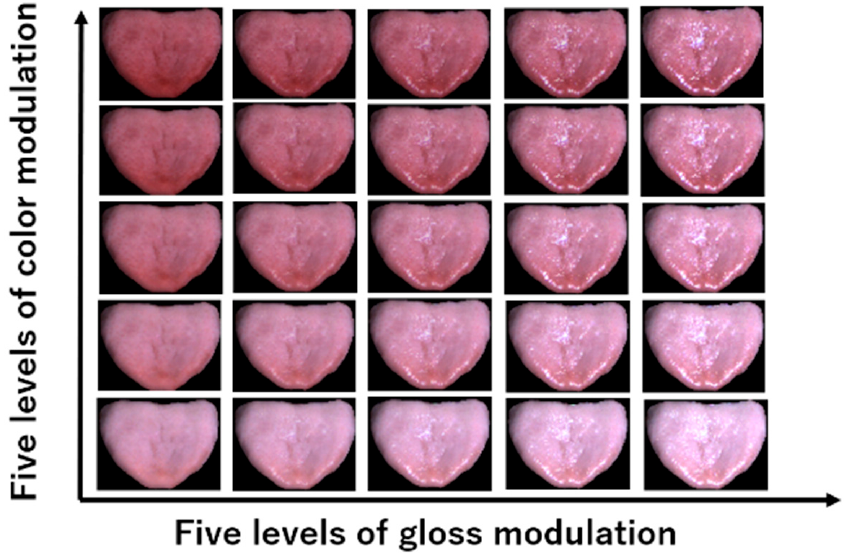
Figure 6. Data augmentation by color and gloss modulation.